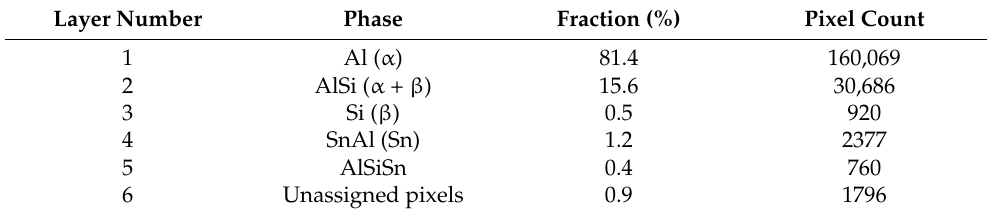
Table 8. Phases in AlSI10Sn1.7 alloy in micro area from Figure 18.